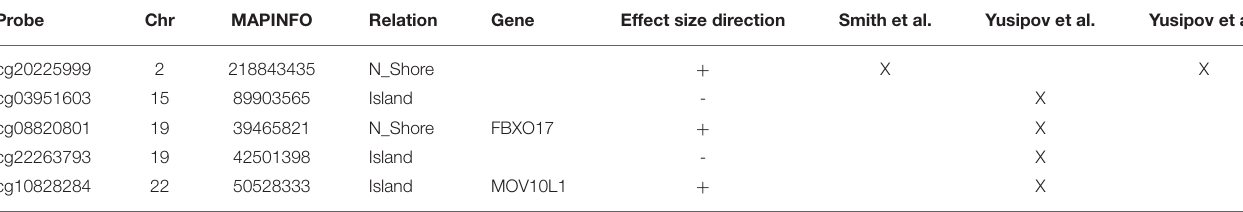
TABLE 7 | Probes resulting from the intersection between aDMPs, sDMPs, and AD-DMPs in TC. Probe Chr MAPINFO Relation Gene Effect size direction Smith et al. Yusipov et al. Yusipov et